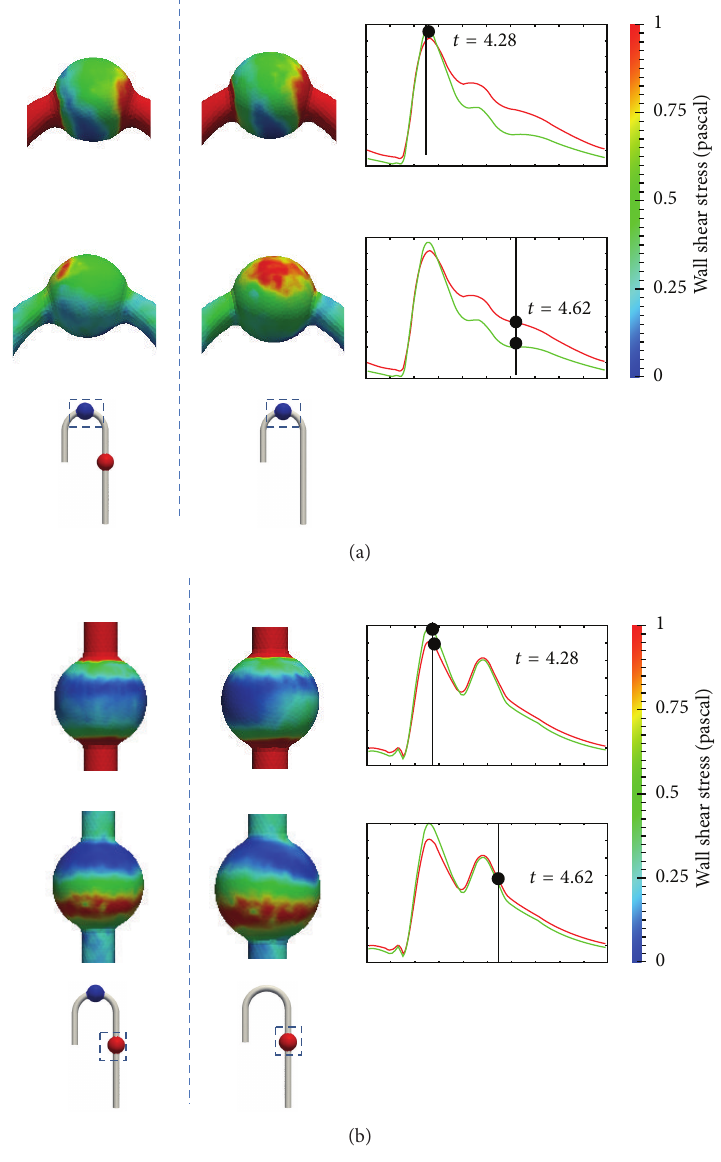
Figure 10: Wall shear stress contour comparison: (a) TAA, (b)